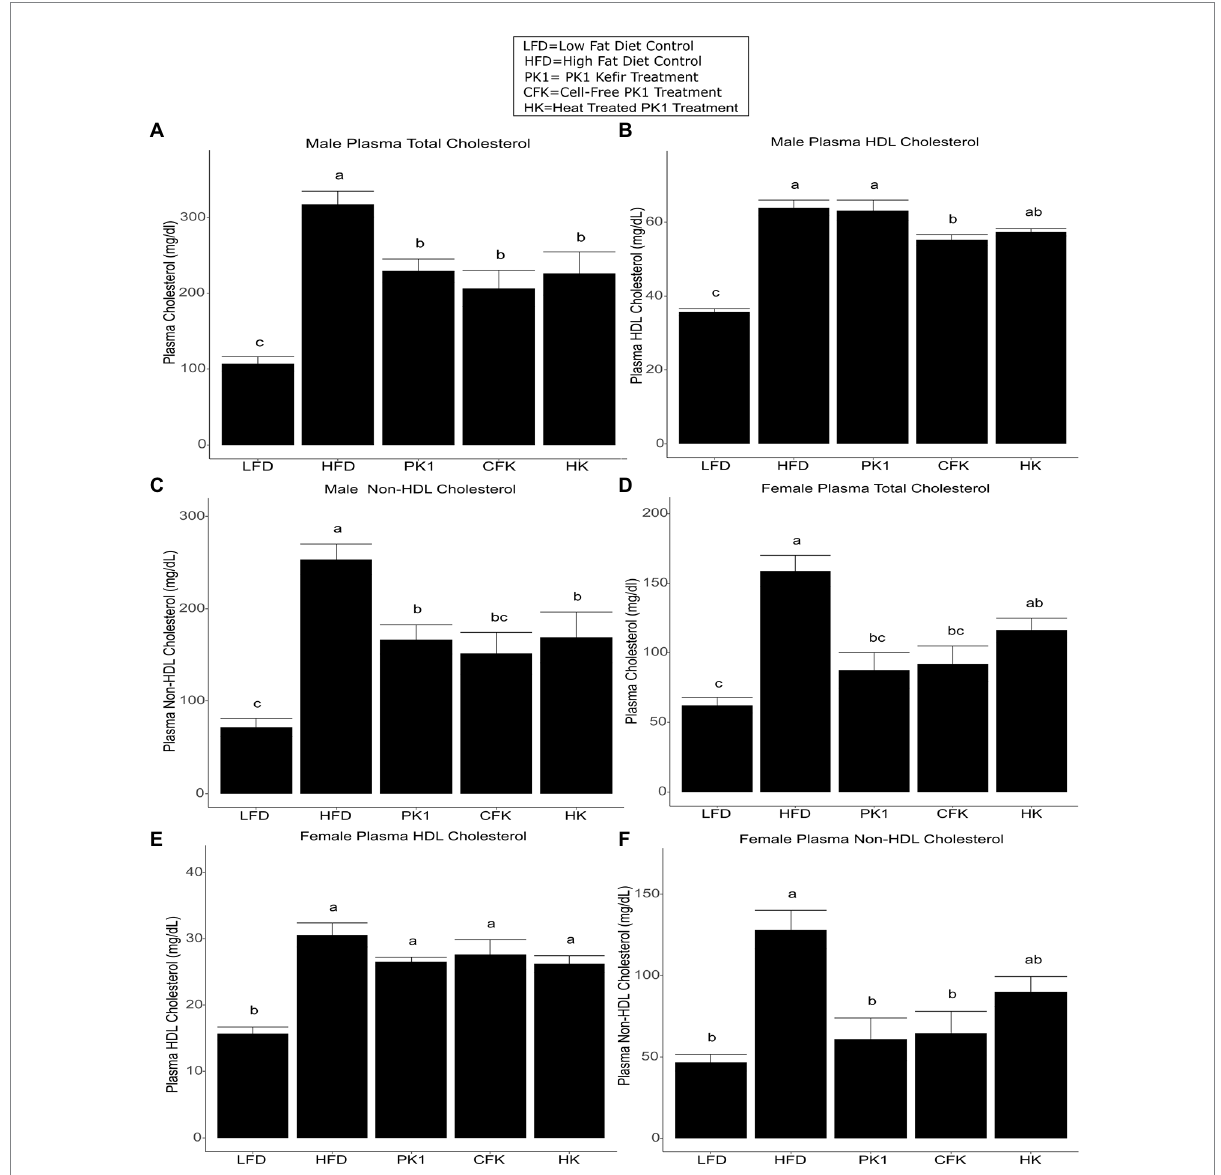
FIGURE 2 Concentration of total plasma cholesterol (A,D) , HDL cholesterol (B,E) , and non-HDL cholesterol (C,F) in male/female C57Bl/6 mice fed a control diet or high-fat diet supplemented with milk or different kefir preparations for 8 weeks. Data are expressed as mean values with their standard errors ( n = 7–8). Means that do not share a letter are significantly different ( p < 0.05). LFD, mice fed a low fat diet supplemented with freeze-dried milk for 8 weeks; HFD, mice fed a high fat diet supplemented with freeze-dried milk for 8 weeks; PK1, mice fed a high fat diet supplemented with freeze-dried pitched kefir for 8 weeks; CFK, mice fed a high-fat diet supplemented with freeze-dried cell-free kefir; HK, mice fed a high-fat diet supplemented freeze-dried heat-treated